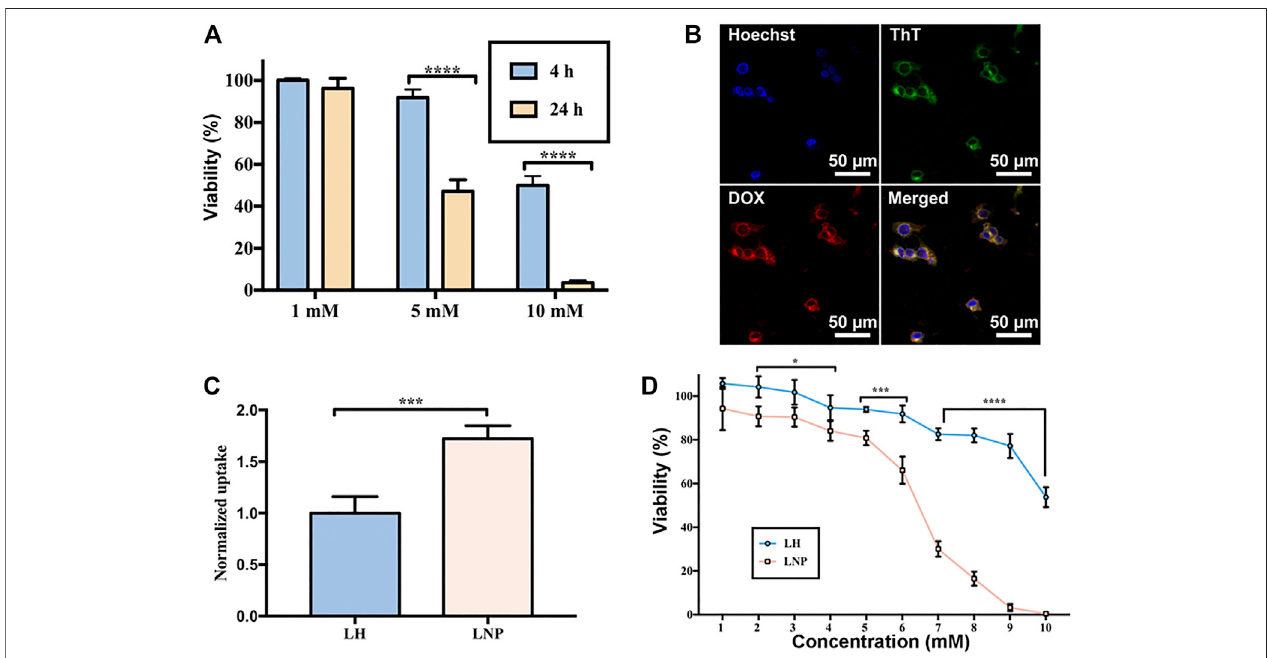
FIGURE 2 | Enhanced cellular uptake and cytotoxicity of LNPs. (A) cytotoxicity of LH incubated with A375 cells for 4 or 24 h. (B) co-localization of GQY (stained green by ThT) and encapsulated DOX (red) in A375 cells. (C) cellular uptake of LH and LNPs. (D) cytotoxicity of LH and LNPs with 4-h of incubation. * p < 0.05, *** p < 0.001,**** p < 0.0001 by one-way ANOVA with Tamhane ’ s T2.